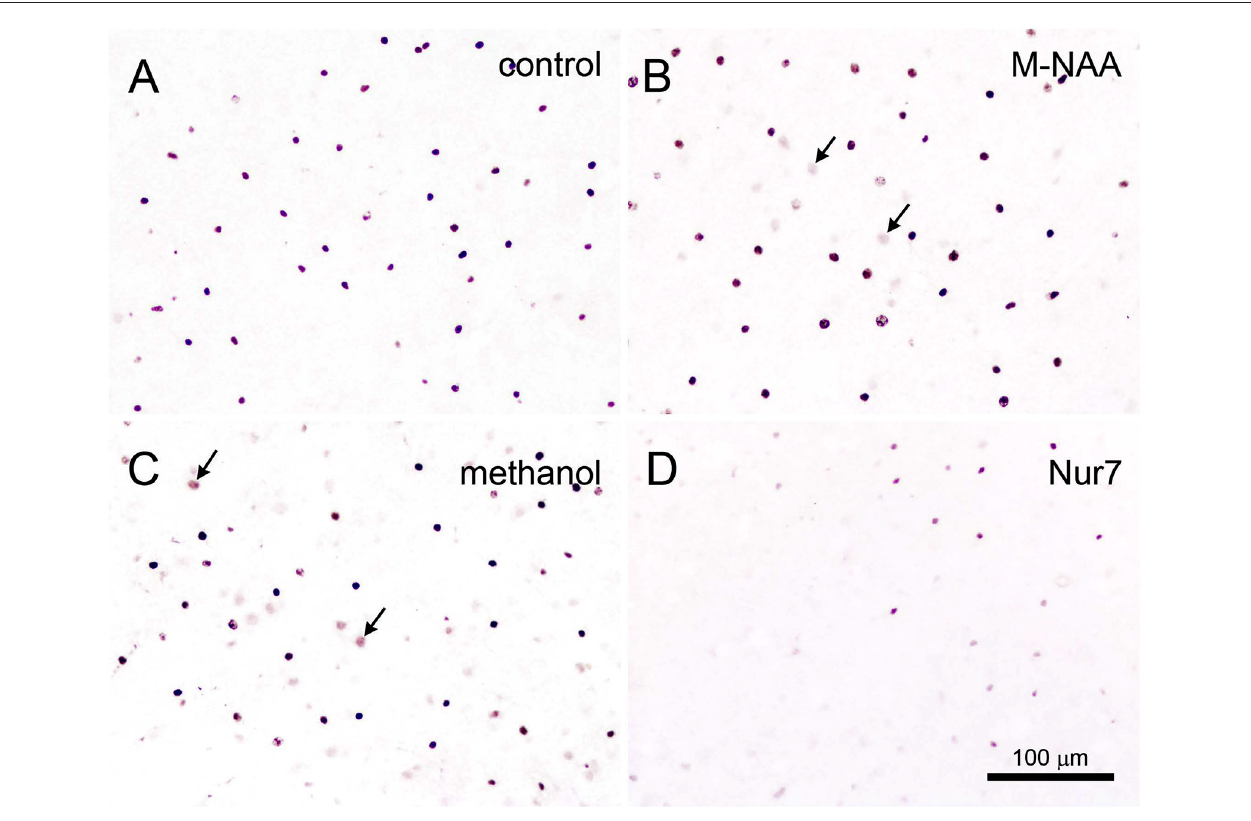
FIGURE 7 | Acyl-CoA short chain synthetase family member 2 (Acss2) immunohistochemistry. Acss2 immunoreactivity was sparse in control mice (A) , occurring almost exclusively in scattered cell nuclei throughout the brain. Immunoreactivity was slightly increased (arrows) in some cell nuclei in the M-NAA (B) and